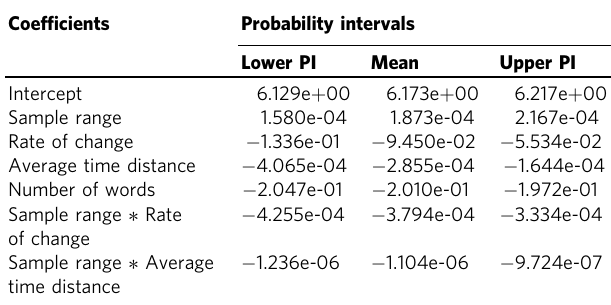
Table 2 Bayesian regression coef fi cients and probability